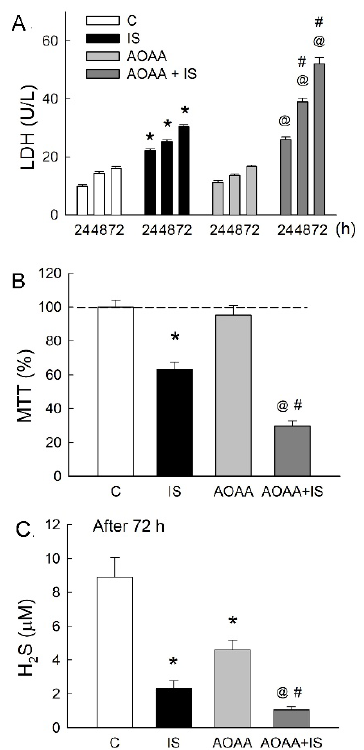
Figure 2. IS impairs H 2 S release in LLC-PK 1 cells. ( A ) A representative tracing showed changes in the recording voltage (mV) in response to a standard solution of NaHS ranging from 0.1 to 100 µ M. The insect graph shows the standard curve of NaHS for six independent determinations. ( B ) Changes in H 2 S levels in culture medium were measured after 24, 48, and 72 h of exposure to the vehicle solution (control, C) or IS treatment. N = 6 in each group and time-point. * p < 0.05, IS vs. control (C) group at the same time-point.